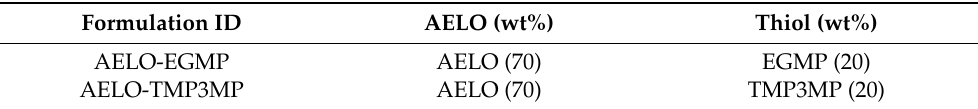
Table 1. Composition of AELO-thiol resins used in this study. Formulations contained 8 wt% DMEP, 2 wt% BAPO, and 0.05 wt% Sudan